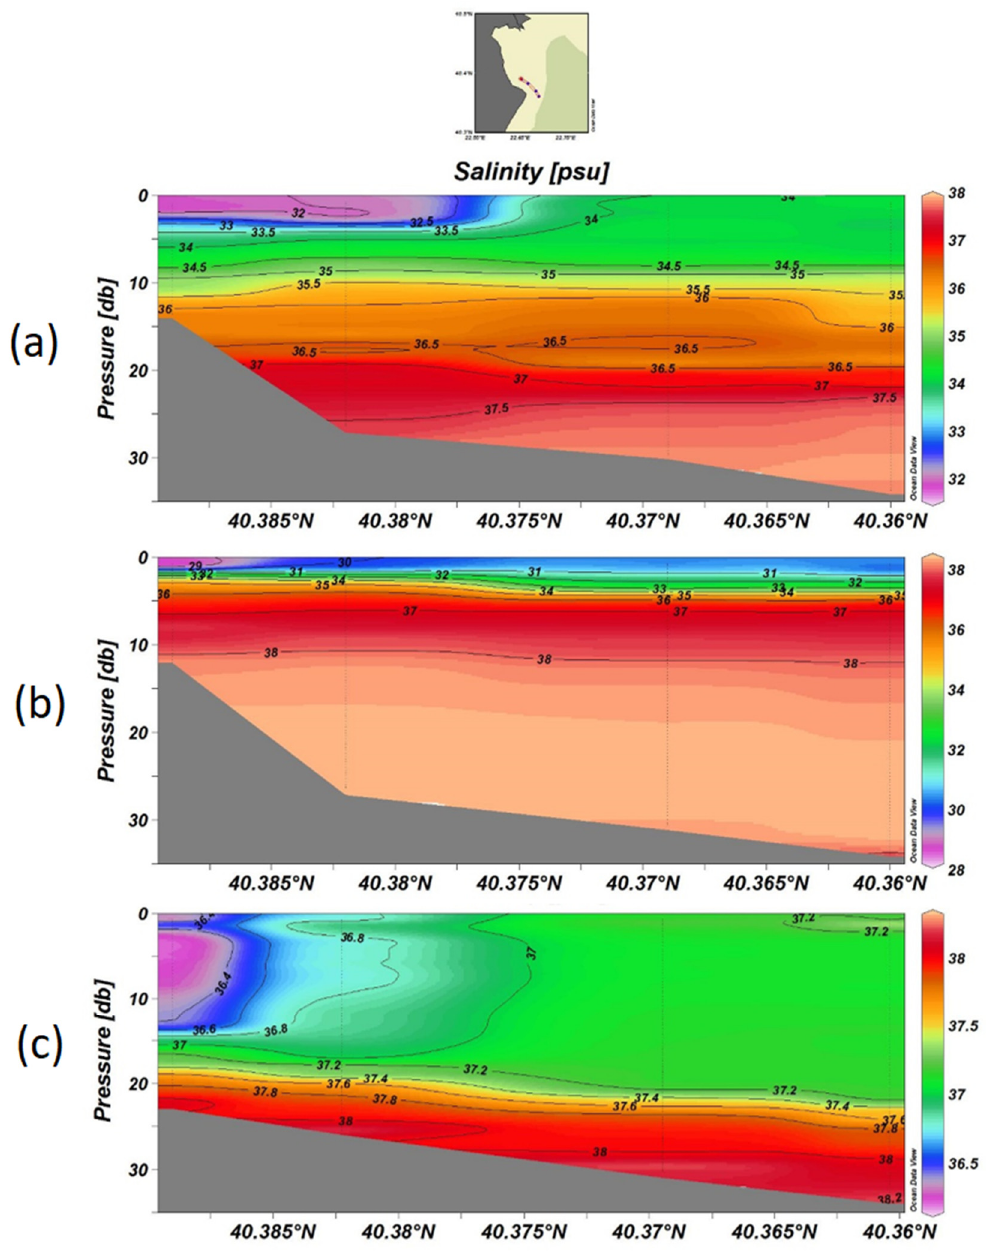
Figure 2. Salinity profile for ( a ) July 2015, ( b ) April 2016, and ( c ) September 2017 in the transects of stations 1, 3, 4, and 5 (north to east).